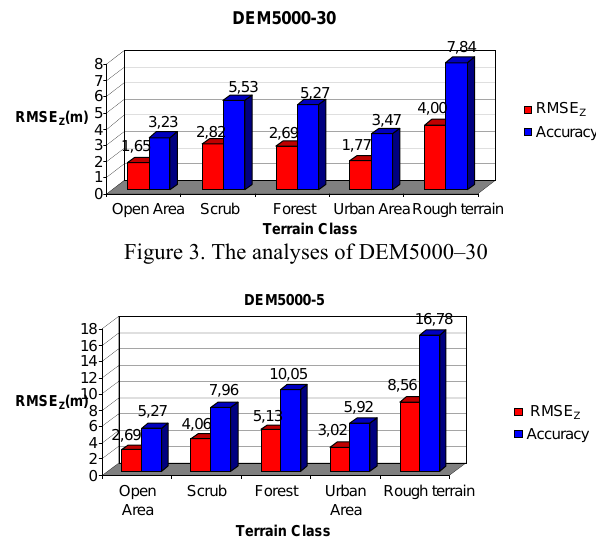
Figure 4. The analyses of